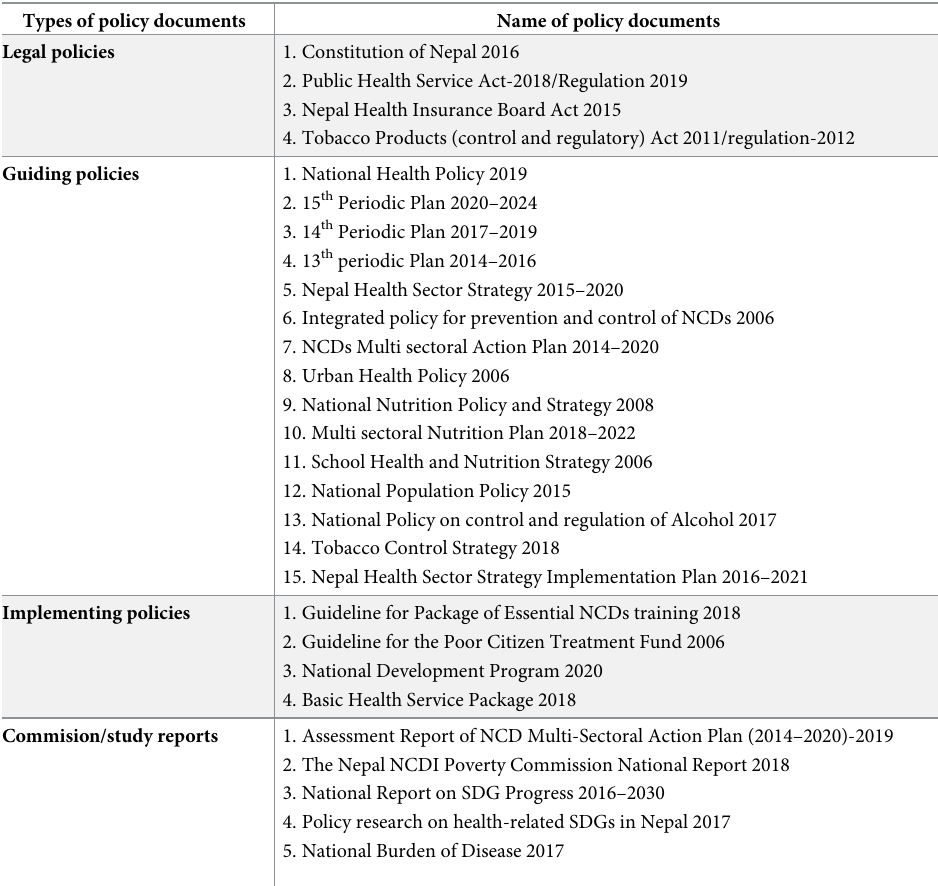
Table 1. List of policy documents.